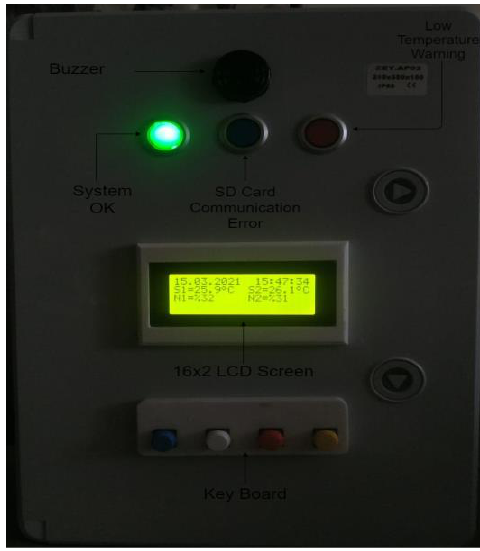
Figure 2.3. The front surface of the electrical panel.